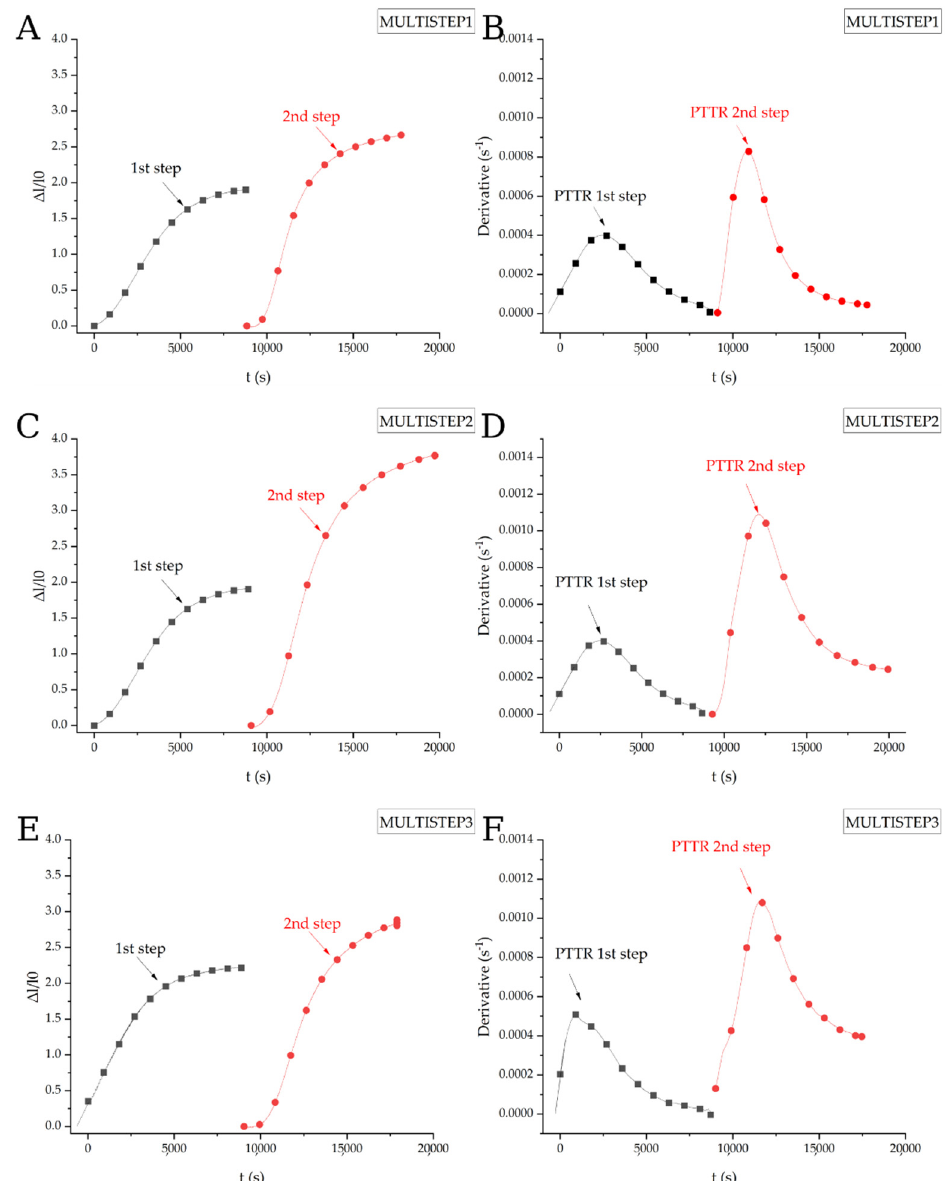
Figure 5. ( A , C , E ) relative change in length vs. austempering time curve for the heat treatment MULTISTEP 1, MULTISTEP 2, MULTISTEP 3, respectively. ( B , D , F ) Derivative of the relative change in length against time treatment describing the kinetic of the bainitic transformation during MULTISTEP 1, MULTISTEP 2, MULTISTEP 3 respectively.